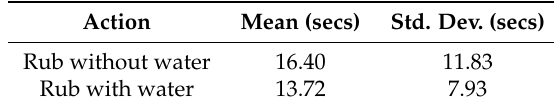
Table 9. Statistics for the duration of each action in the ground